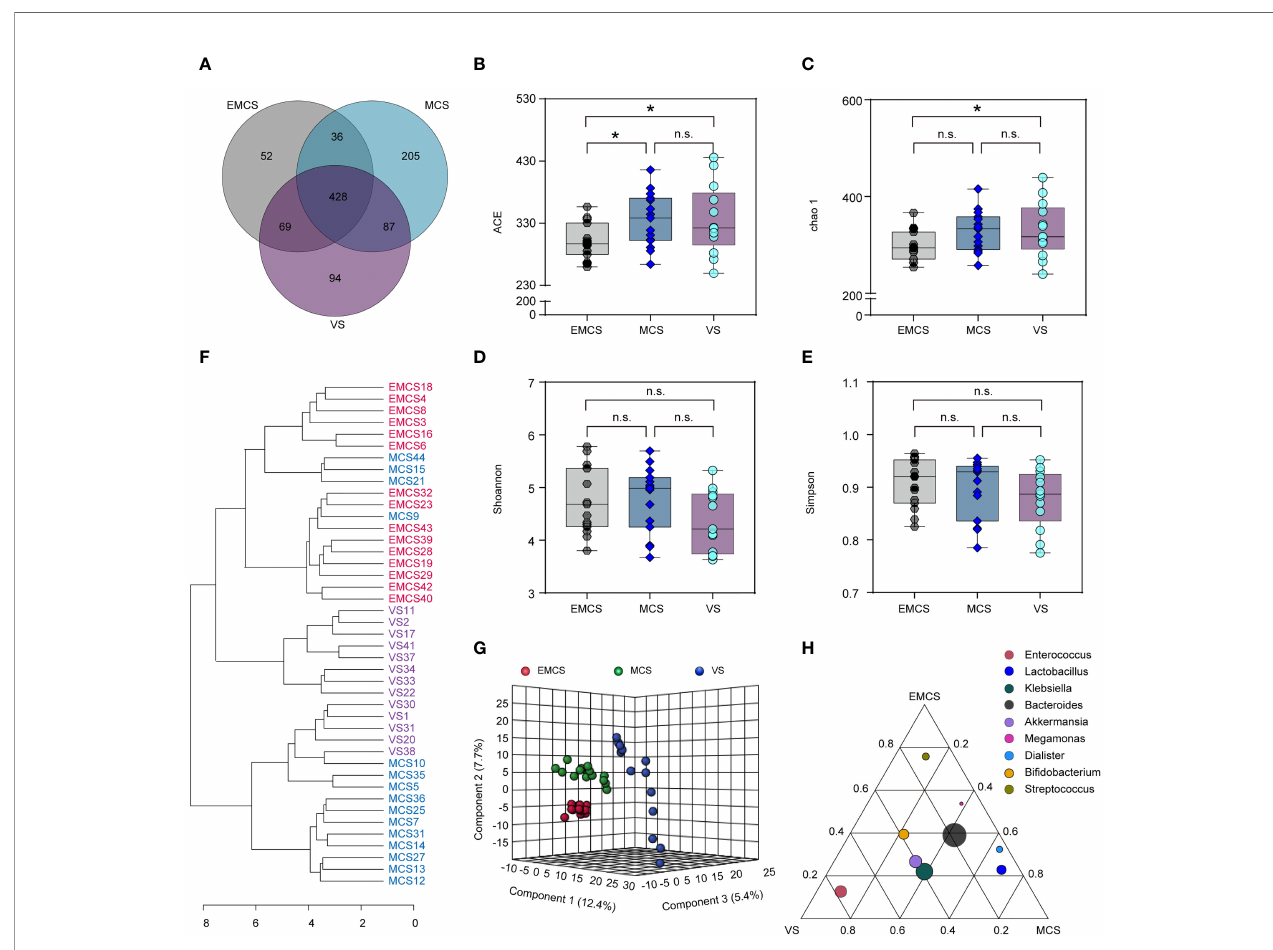
FIGURE 1 | Changes in the fecal microbial diversity and community structures of EMCS, MCS, and VS patients. (A) Venn diagram showing the overlap of the operational taxonomic units of the fecal microbiota across the three groups. (B – E) The a -diversity of the fecal microbiomes of three groups depicted according to ACE, Chao1, Shannon, and Simpson indices. Each box plot represents the median, interquartile range, minimum, and maximum values. (F) Dendrogram of the EMCS, MCS, and VS groups showing the clustering of all 43 samples. (G) PLS-DA score plots of the relative abundances of the microbiota in the EMCS, MCS, and VS groups. Three components explained 25.5% (12.4%, 5.4%, and 7.7%) of the variance among the three groups. Component scores are indicated as percent. Circles indicate individual samples from the EMCS, MCS, and VS groups. (H) Ternary plot depicting the number of genera (top 10 relative abundance) enriched in the EMCS, MCS, and VS groups. Each circle represents one genus, and the size of the circle re fl ects the relative abundance. P -values were determined using one-way ANOVA or the Kruskal – Wallis test. * p < 0.05; n.s. , no signi fi cant difference. EMCS , emerged from minimally conscious state; MCS , minimally conscious state; VS , vegetative state; PLS-DA , partial least squares discriminant